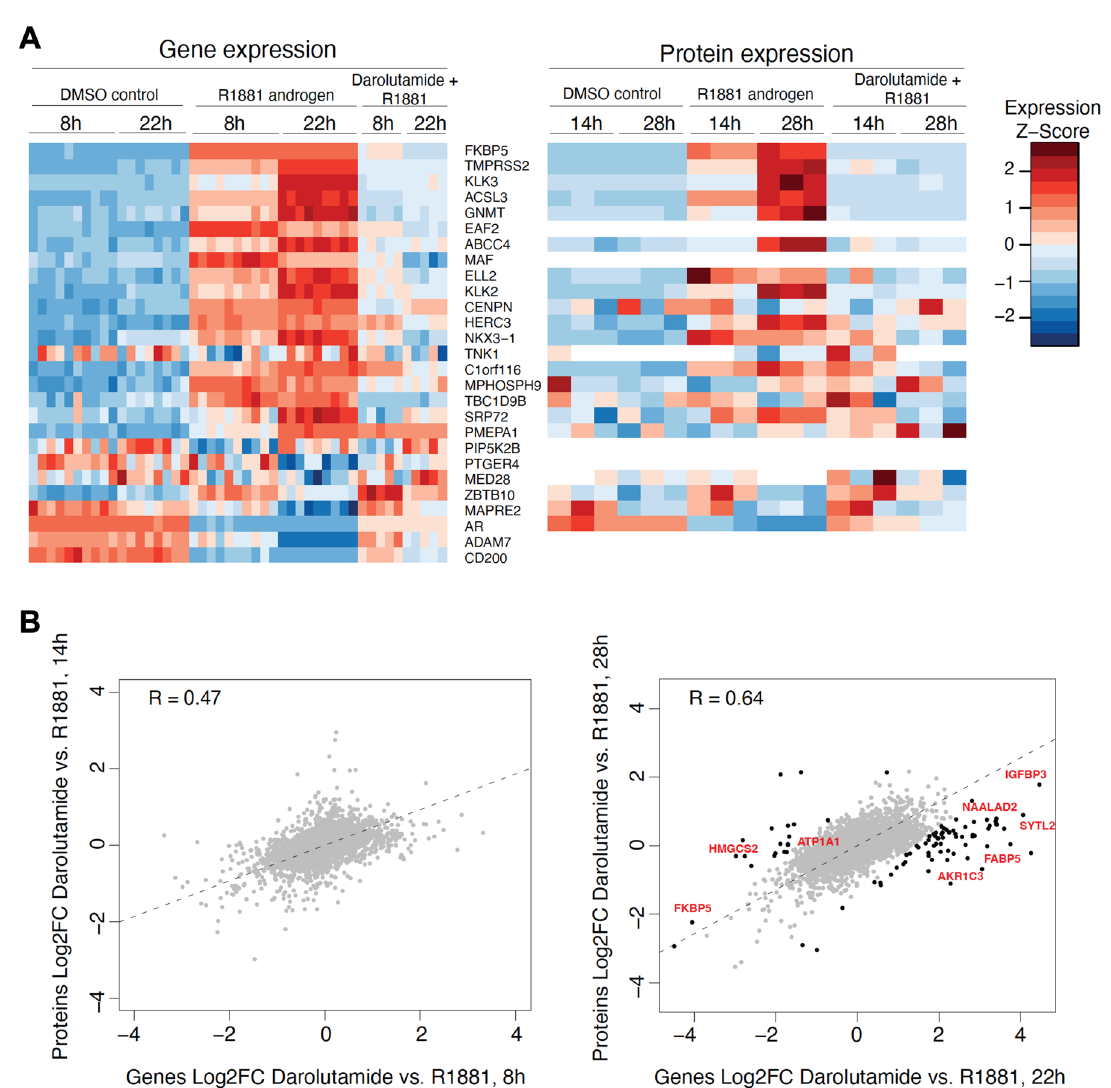
Figure 4. ( A ) Heatmap plots of mRNA ( left side ) and protein ( right side ) levels of AR activity signature genes following treatment of VCaP cells with DMSO, R1881, or R1881 and darolutamide for the indicated times. ( B ) Scatterplots of Log2 fold changes in mRNA and protein abundance upon R1881 and darolutamide treatment compared to R1881 treatment alone. Gene expression after 8 h and protein level after 14 h of treatment was determined as early time point ( left side ). Gene expression after 22 h and protein level after 28 h of treatment was determined as late time point ( right side ). Genes with differential magnitude of response on the mRNA and protein levels are indicated in black, a few selected androgen targets are